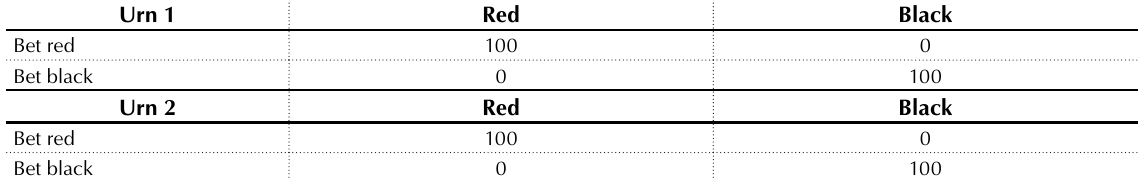
Table 2. Decisions, outcomes and payoffs of ambiguous urn (Urn 1) and risky urn (Urn 2)